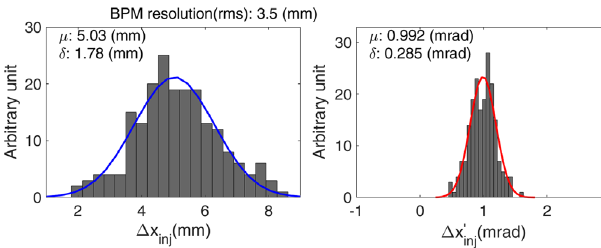
FIG. 8. The detected betatron oscillation at two different BPMs before (blue solid lines) and after (red dashed lines with triangles) the correction for the injection beam.